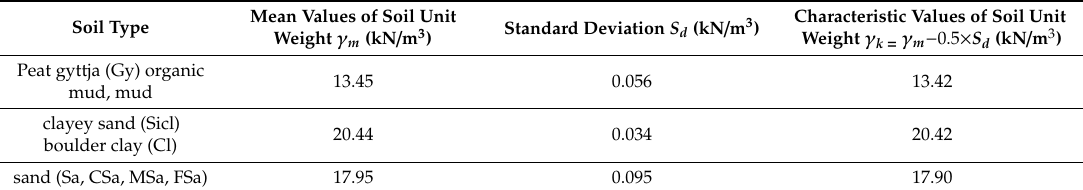
Table 9. Summary of mean characteristic values of soil unit weight obtained from seismic dilatometer (SDMT) tests for the analyzed sites (peat, gyttja (Gy)), organic mud, mud, clayey sand (Sicl), boulder clay (Cl), and sand (Sa, CSa, MSa, FSa).